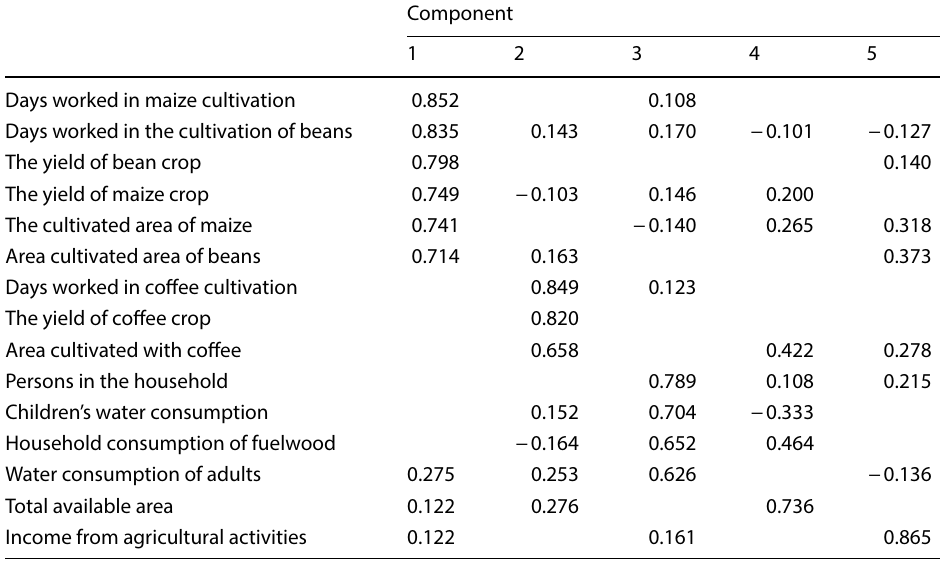
Table 3 Rotated component matrix